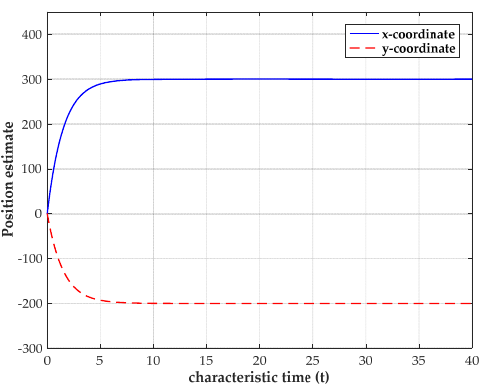
Figure 3. Transient behavior of the estimated source coordinates with the source position located at ( 300, − 200 ) m. Sensors 2018 , 18 , x FOR PEER REVIEW